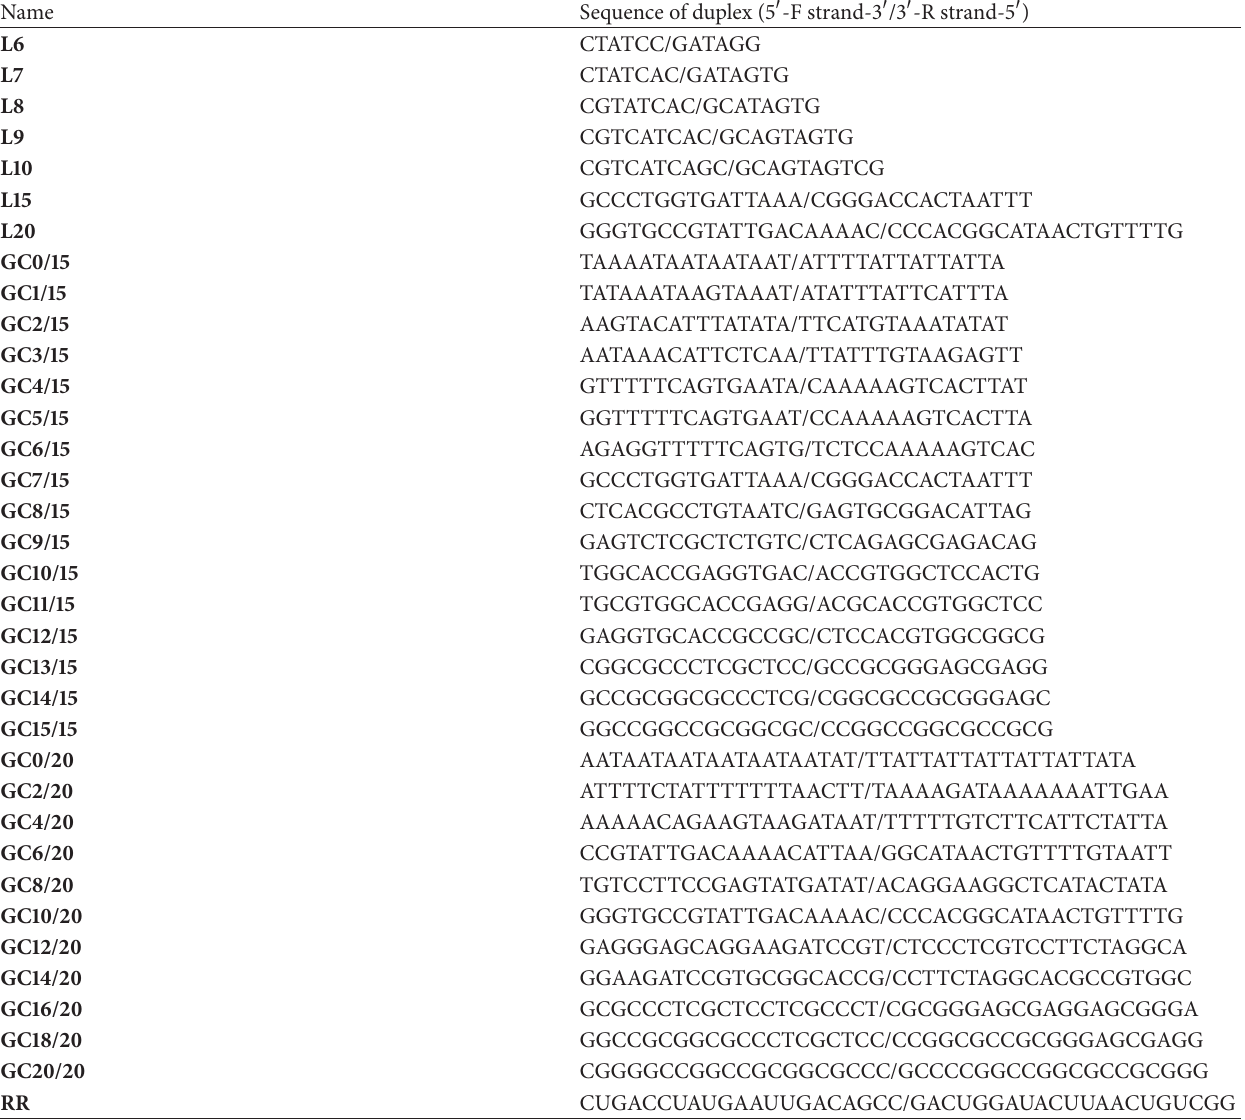
Table 1: Sequences of DNA and RNA duplexes used in this study.